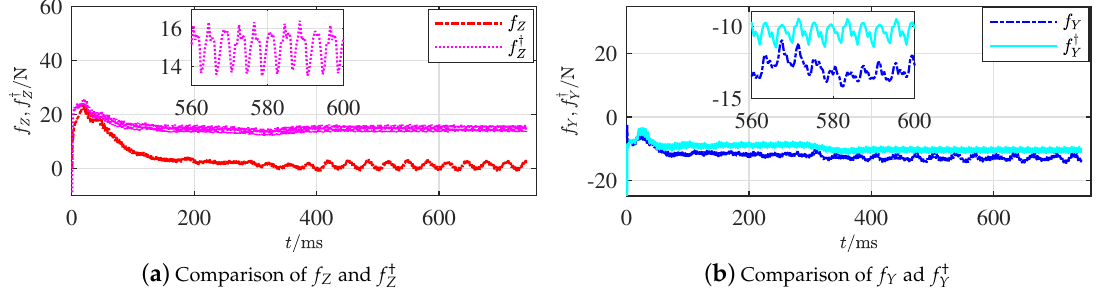
Figure 7. Comparisons of additive forces along axes z b and y b